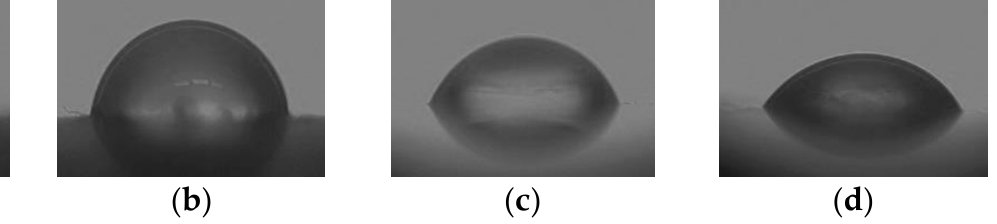
Figure 4. Contact angle measurement results. LDPE 100 ( a ), LDPE/NR 90/10 ( b ), LDPE/NR 70/30 ( c ), LDPE/NR 50/50 ( d ).